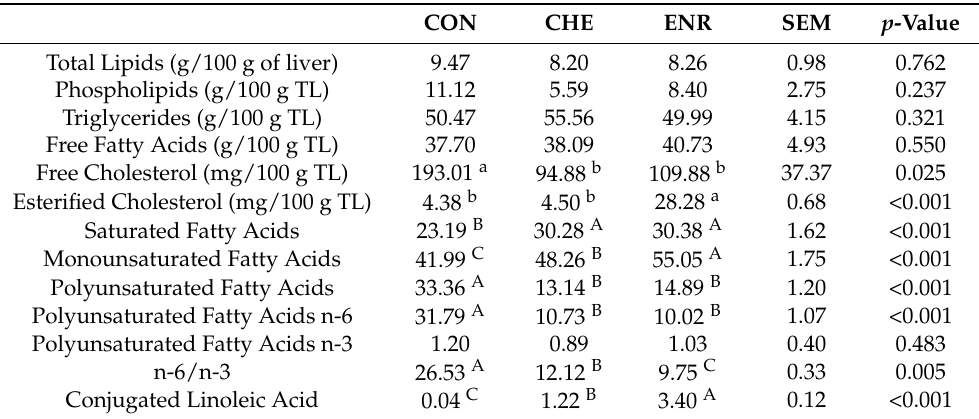
Table 3. Effect of the diet on the lipid profile of the liver. CON CHE ENR SEM